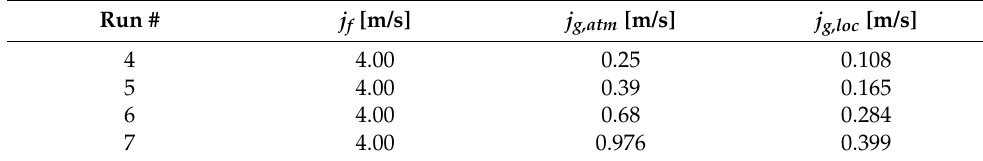
Table 2. Test conditions vertical downward two-phase